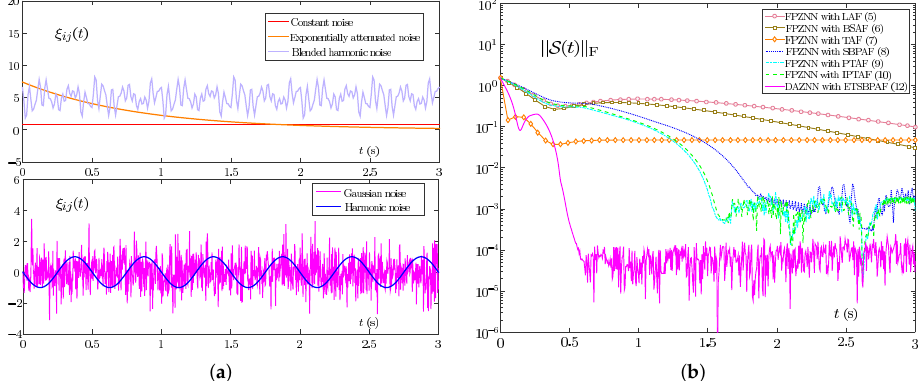
Figure 4. Profile of different noises, and dynamic characteristics of the (cid:107)S ( t ) (cid:107) F by FPZNN model (4) and DAZNN model (14) with noise. ( a ) Profile of different noises. ( b ) With constant noise ξ ij ( t ) = 0.8.